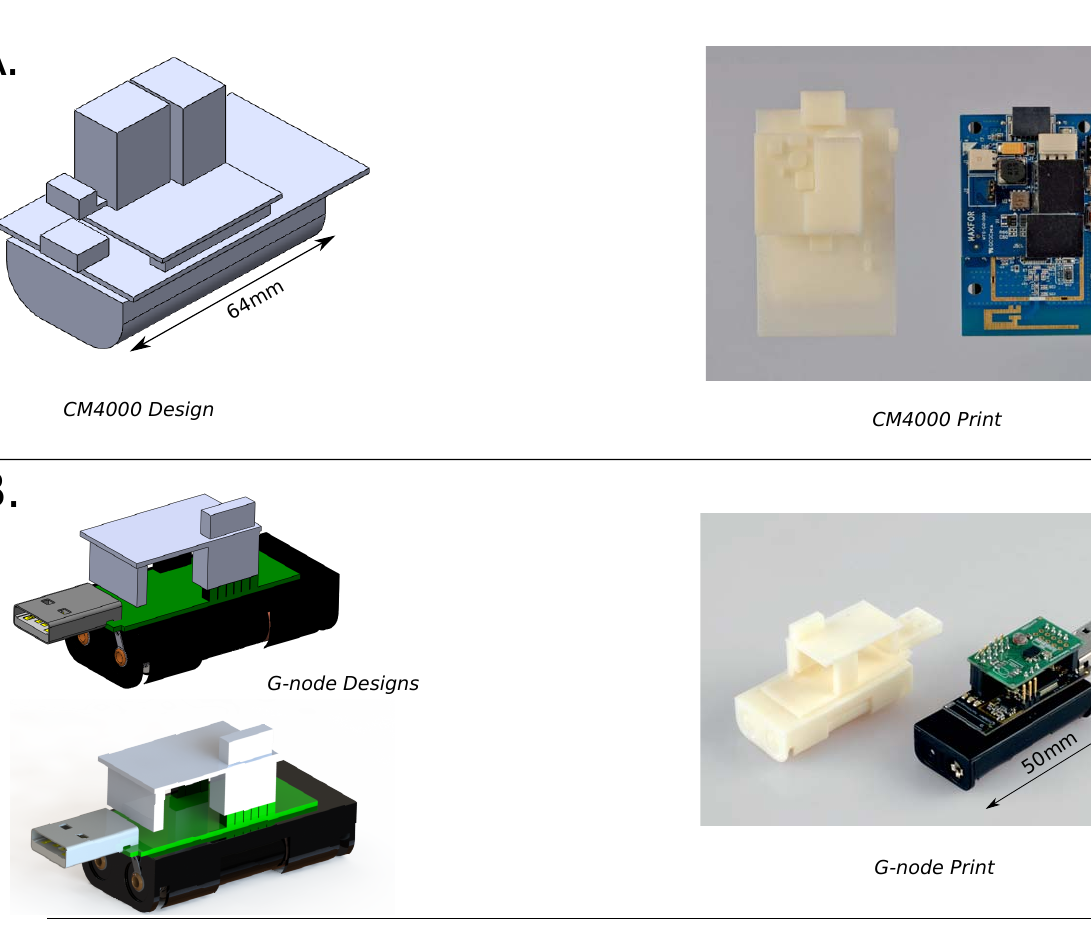
Figure 1. 3D models of tested sensors: ( A ) Digital design (left) and 3D printing, right of the CM4000 sensor mote with the compatible attached sensor board (right). The 3D design of the sensor is the base for the design of the case, making the fit exact; ( B ) Design and 3D printing of the G-node with the compatible G-Colta sensor